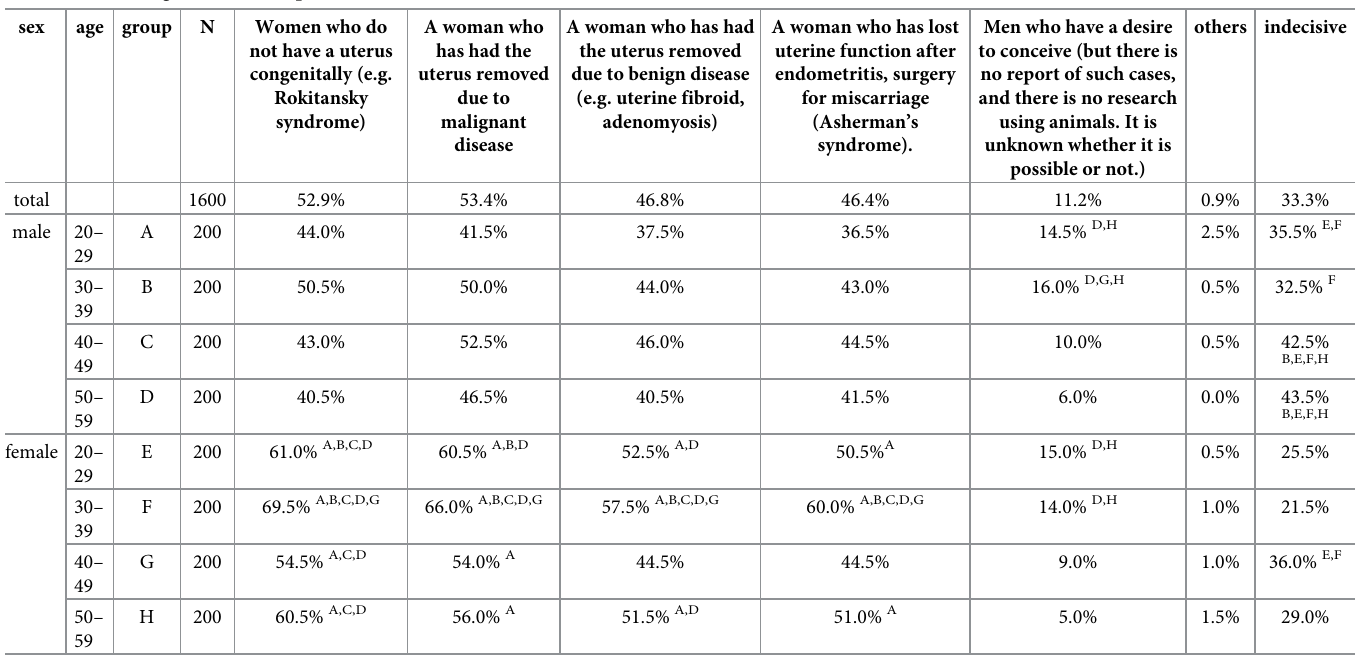
Table 5. Who is eligible to be a recipient of UTx?.